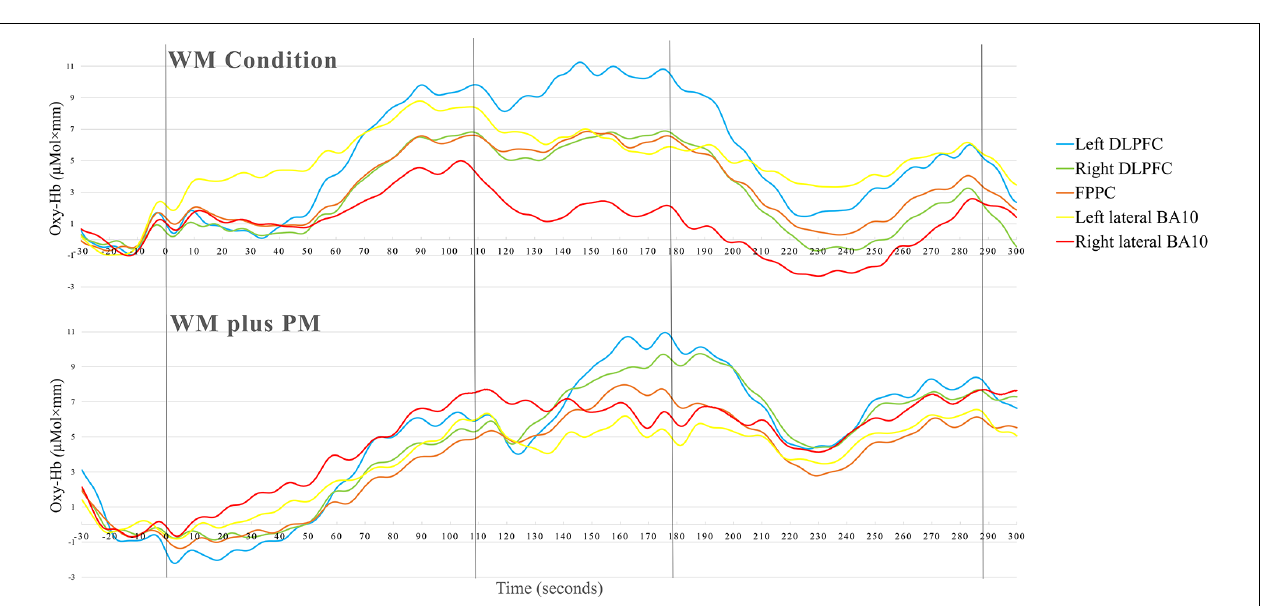
suggests that more cognitive effort is required for a WM plus PM task in comparison to a WM only